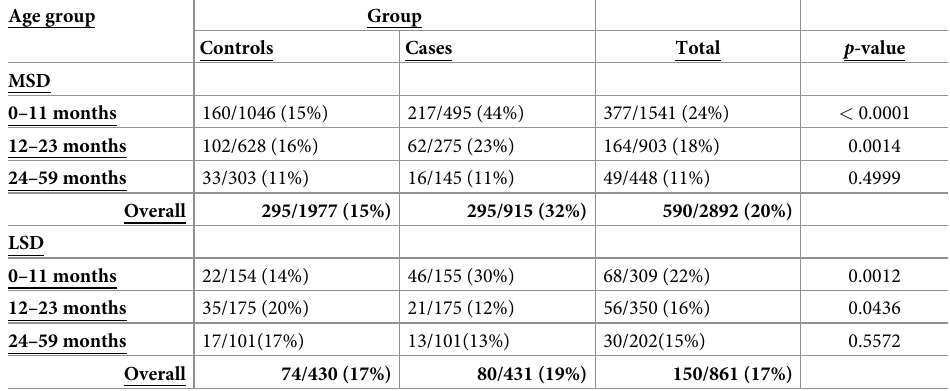
Table 1. Prevalence of rotavirus among children 0–59 months of age with diarrhea (MSD & LSD) and their matched controls.